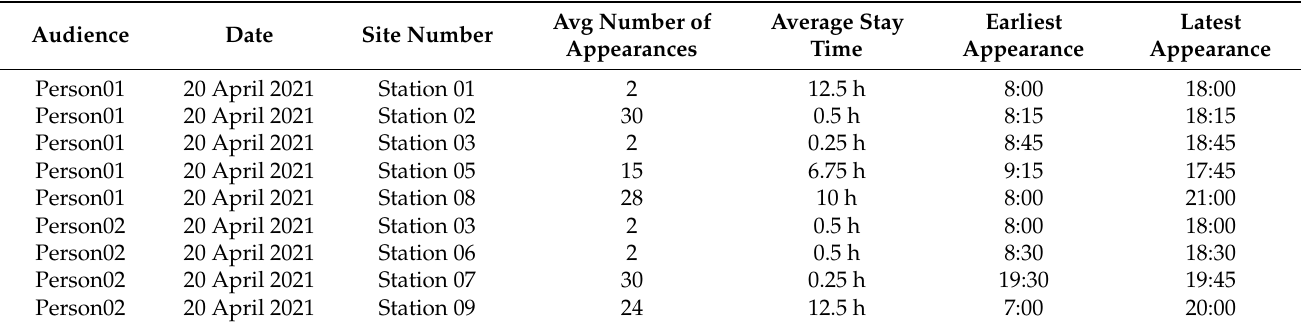
Table 7. Audience’s time and location frequency data.